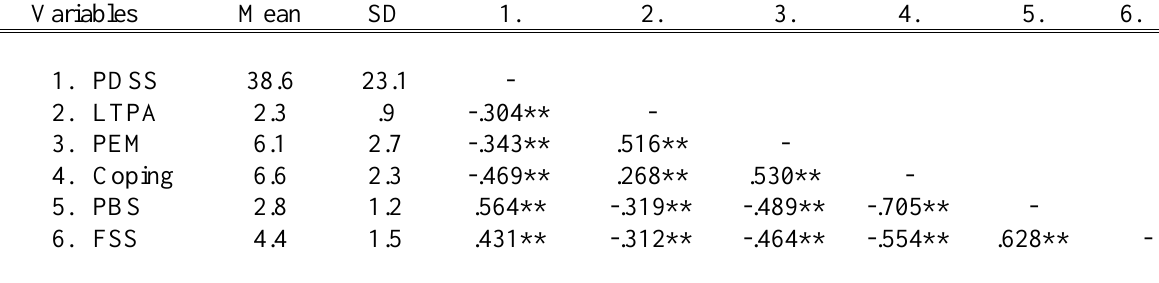
Mean scores and Pearson’s correlations among variables Variables